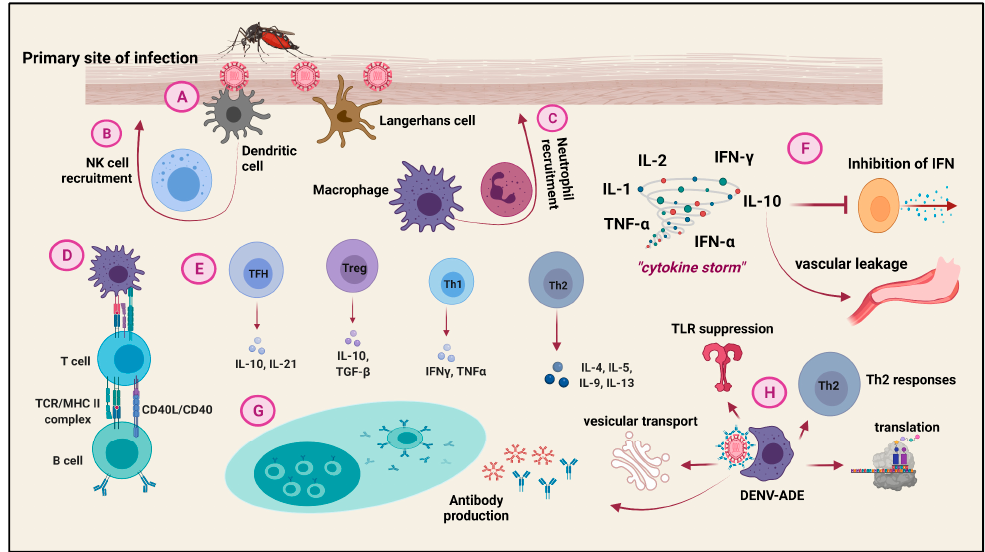
Figure 4. Immune cells involved in the host responses to the Dengue virus: After the mosquito bite injects the Dengue virus into the skin, A. The Langerhans cells and the Dendritic cells (DCs), the primary cells that encounter the Dengue virus, come into play. B. The DCs recruit the NK cells to the site, whereas, C. The macrophages recruit the neutrophils. D. Macrophages infected with DENV present the processed antigen to the T cell, which in turn interacts with the B cell to aid in B cell development. E. Different types of T cells are activated to elicit various cell-mediated immune responses against the virus. F. A gush of cytokines are secreted in an event called the “cytokine storm”, out of which the overproduction of IL-10 leads to the inhibition of IFN responses as well as vascular leakage. G. The humoral immunity, represented by the B-cell-mediated antibody production from the plasma cells, as a natural immune response to any pathogen, induces ADE in the DENV infection. H. The ADE of the DENV entry into the macrophage via phagocytosis leads to an altered transcriptome of the cell, ultimately leading to TLR suppression, enhanced Th2 responses, along with the dysregulation of vesicular transport and the host translation process.